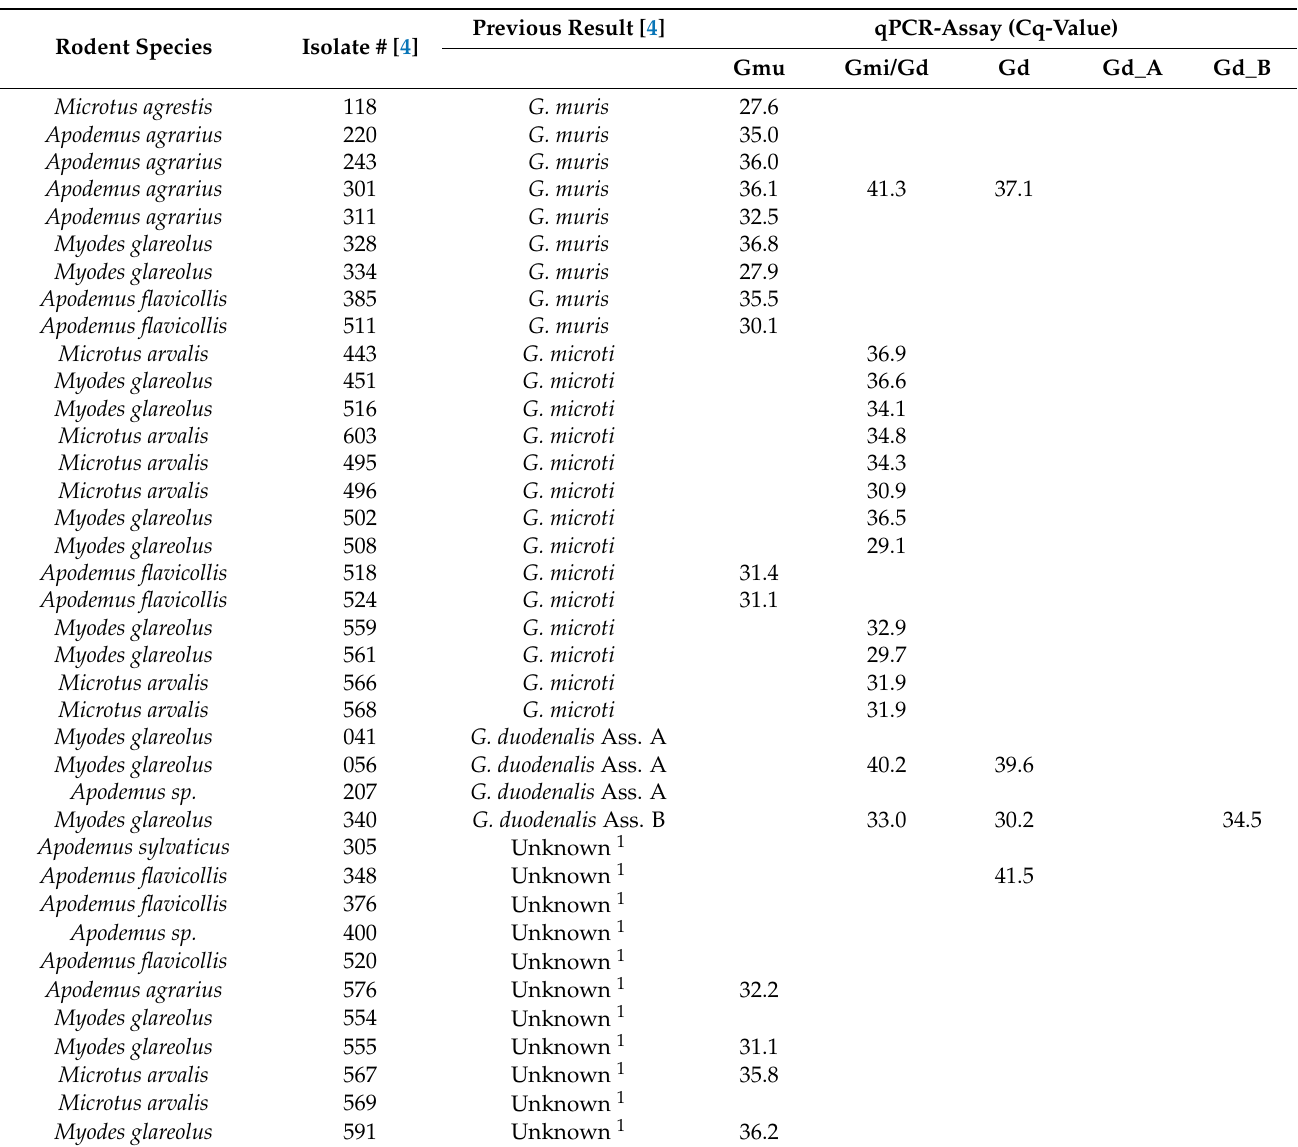
Table 3. Analysis of Giardia -positive wild rodent samples to determine the underlying Giardia species. Reanalysis of selected Giardia -positive samples from reference [4] by the established qPCR